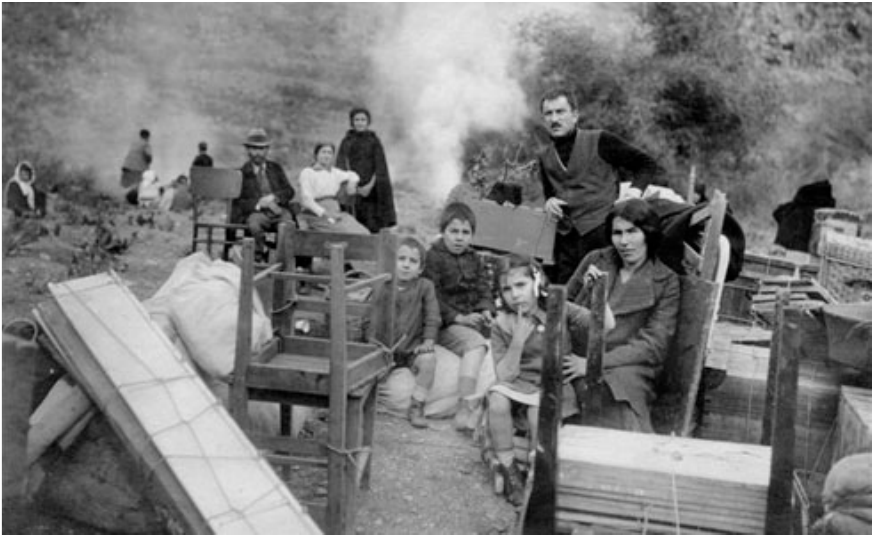
Figure 1. Jews expelled from Jaffa and Tel Aviv, 1917, The Central Zionist Archives.